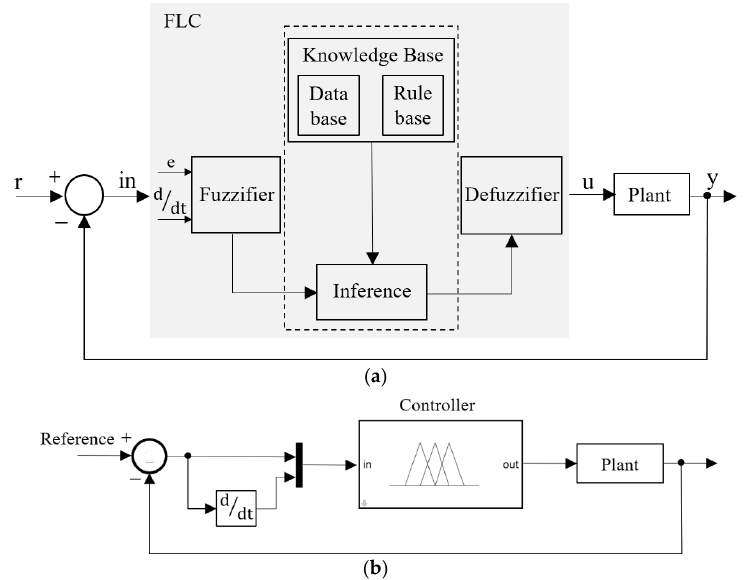
Figure 3. Fuzzy controller designed. ( a ) Diagram of FLC controller. ( b ) Block diagram of implemen- tation in Simulink.